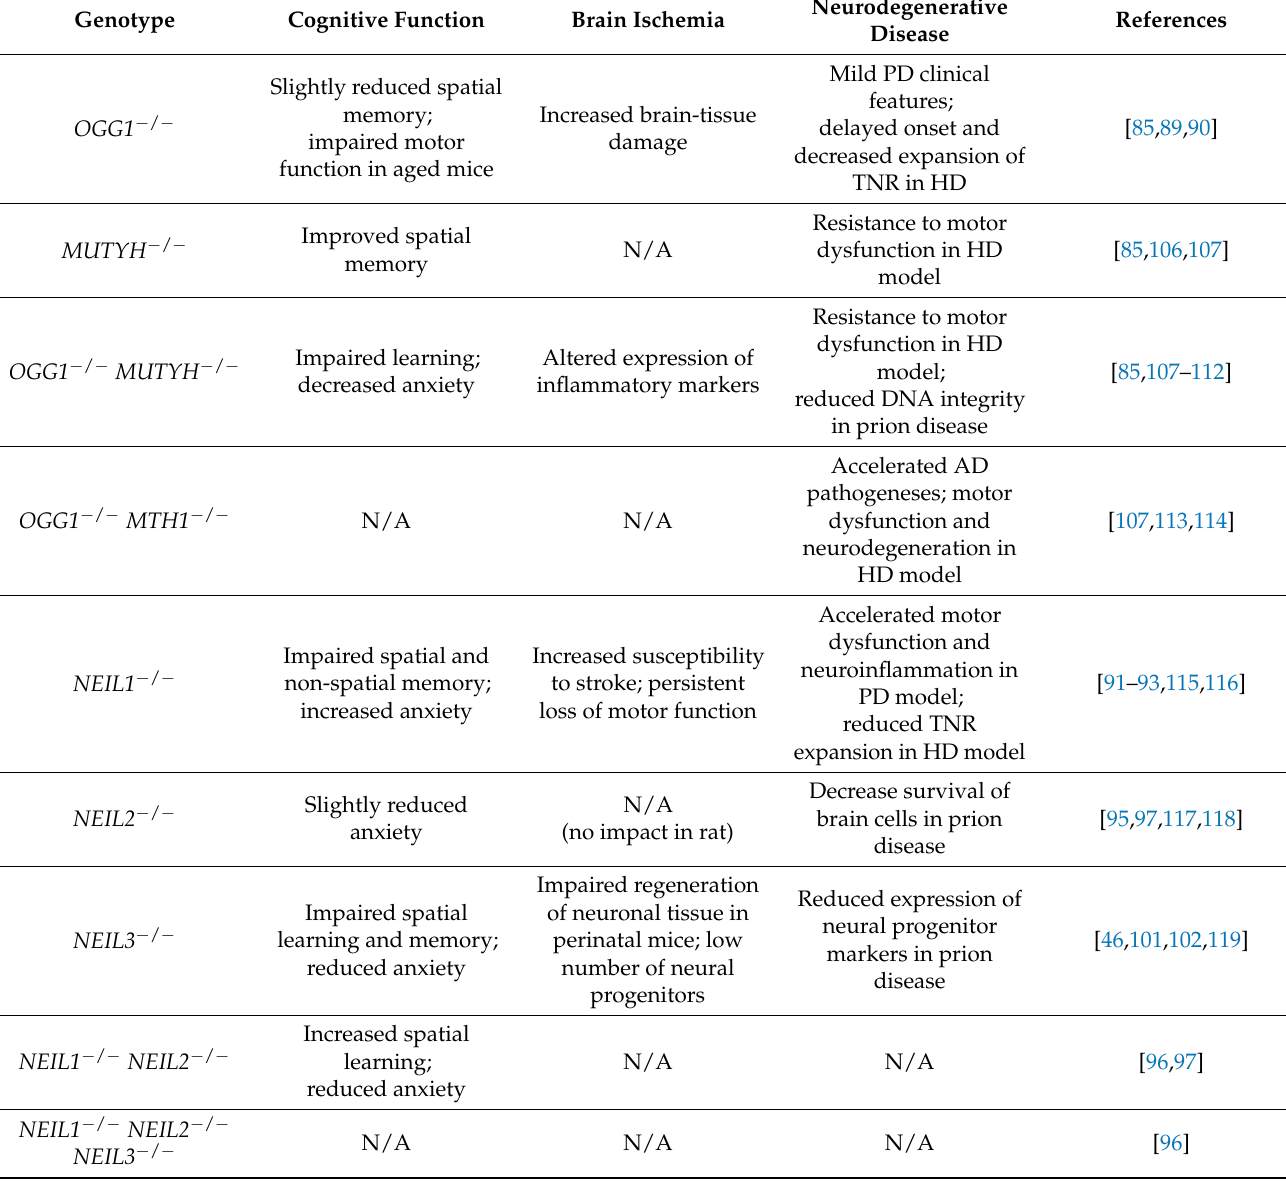
Table 1. Features of mice lacking DNA glycosylase removing oxidative base lesions and the impact of DNA glycosylase loss in cognition and